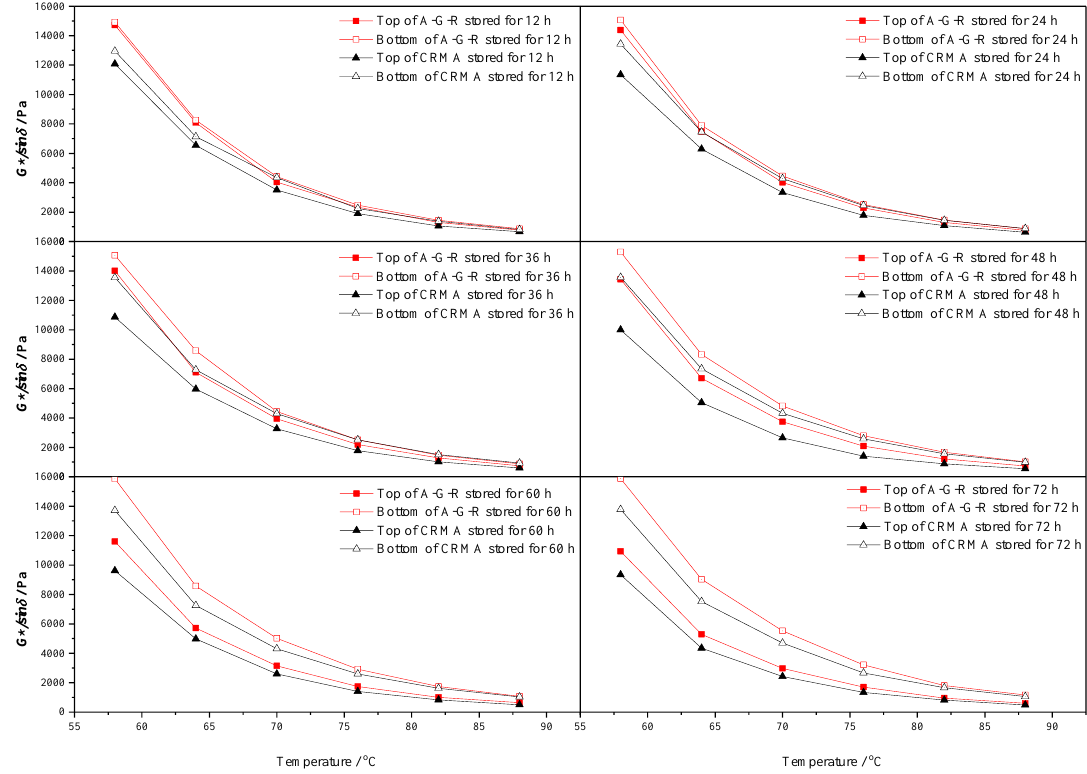
Figure 11. The rutting factor-temperature curves of CRMA and A–G–R.